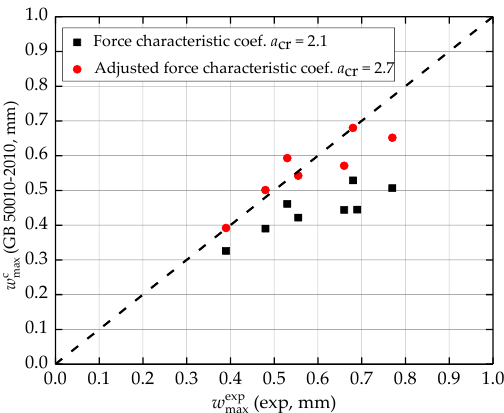
Figure 14. Comparison of crack widths calculated using the modified formula with the experimental crack widths.